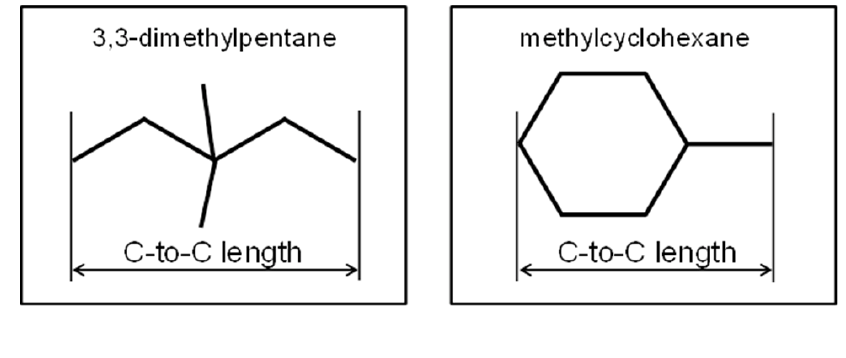
Figure 1. The definition of C-to-C length, which is the longest distance between two carbon atoms in a LMGS. Two molecules are shown are